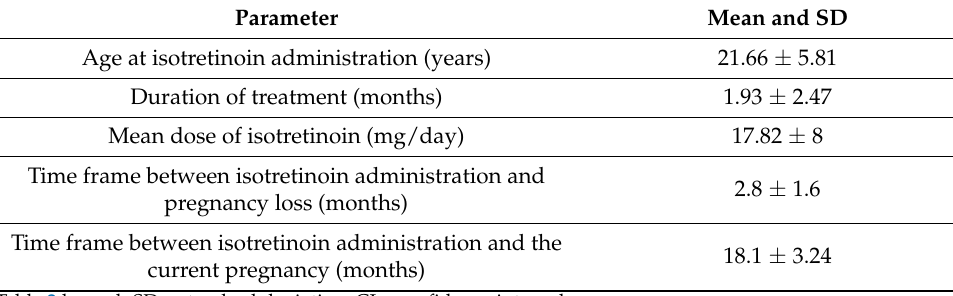
Table 2 legend: SD—standard deviation; CI—confidence interval.